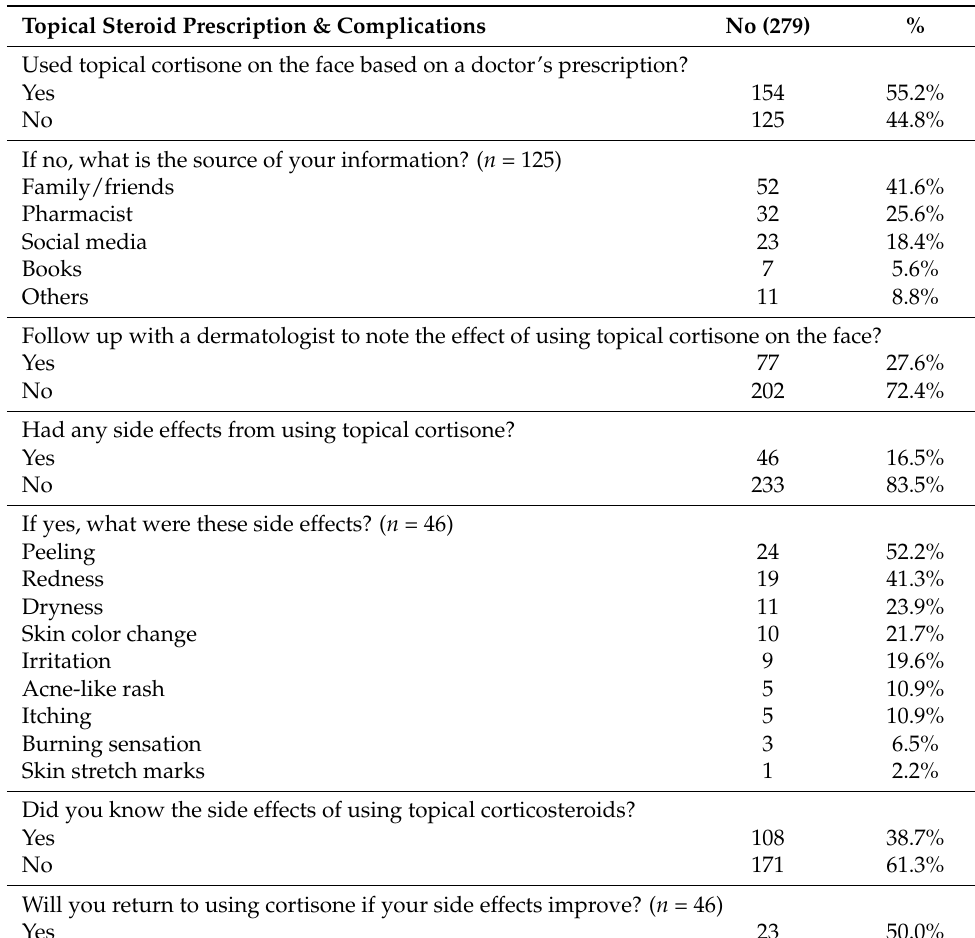
Table 2. Distribution of topical corticosteroids prescribed use and its complications